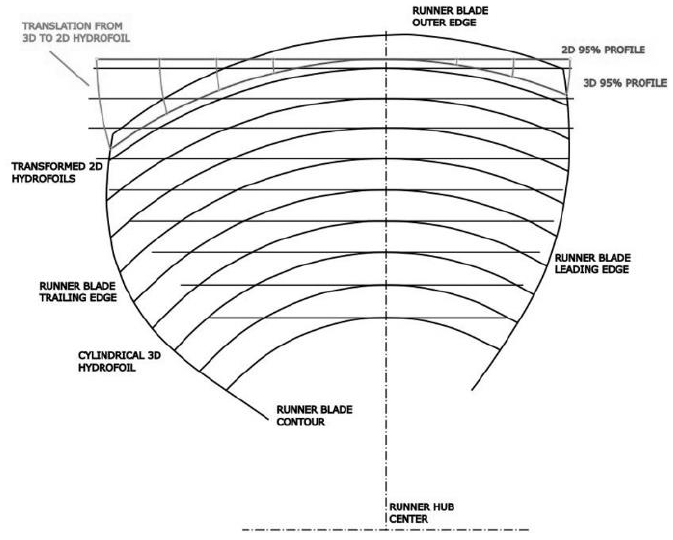
Figure 3. Bulb turbine blade design from individual 2D hydrofoils.